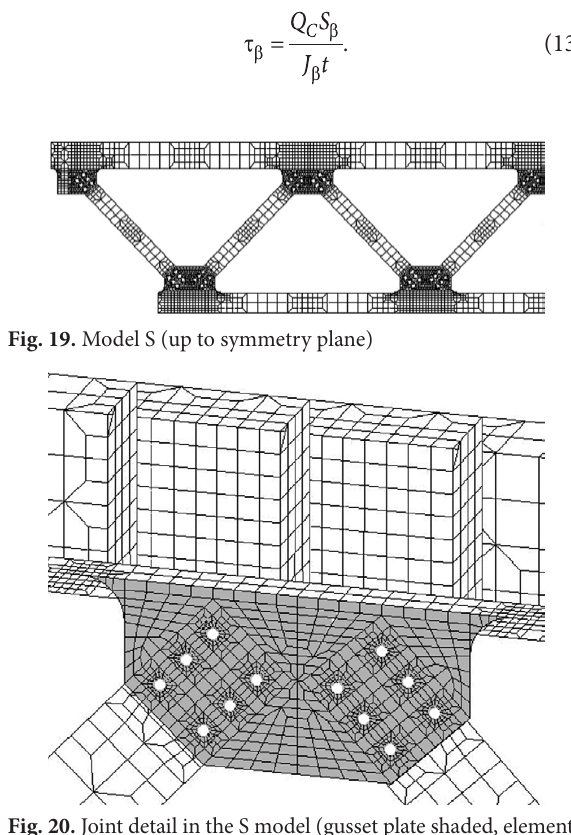
Fig. 20. Joint detail in the S model (gusset plate shaded, elements modelling bolts omitted)